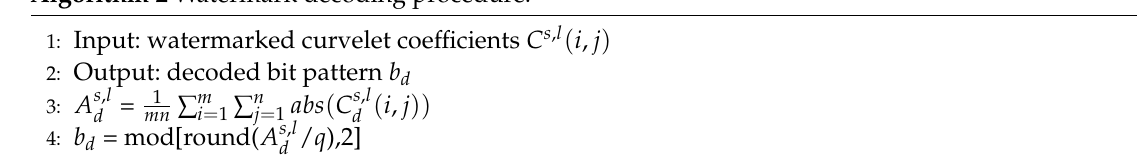
Algorithm 2 Watermark decoding procedure.